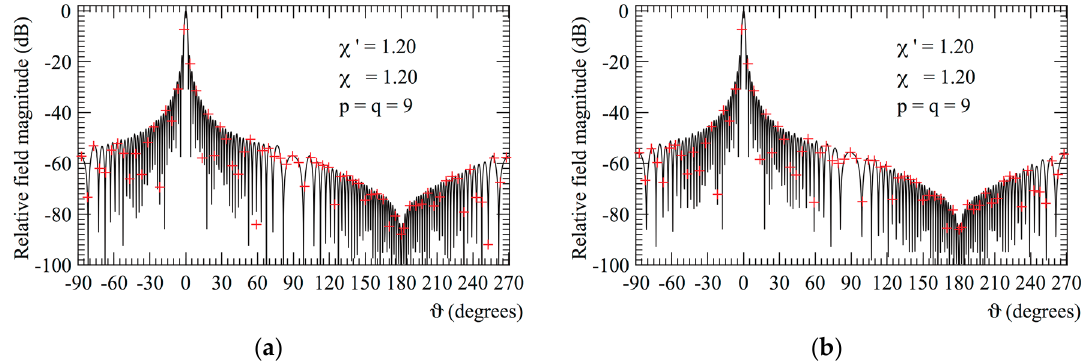
Figure 5. Far-field pattern. ――― exact. + + + + interpolated from the non-redundant samples: ( a ) E-plane; ( b ) H-plane.